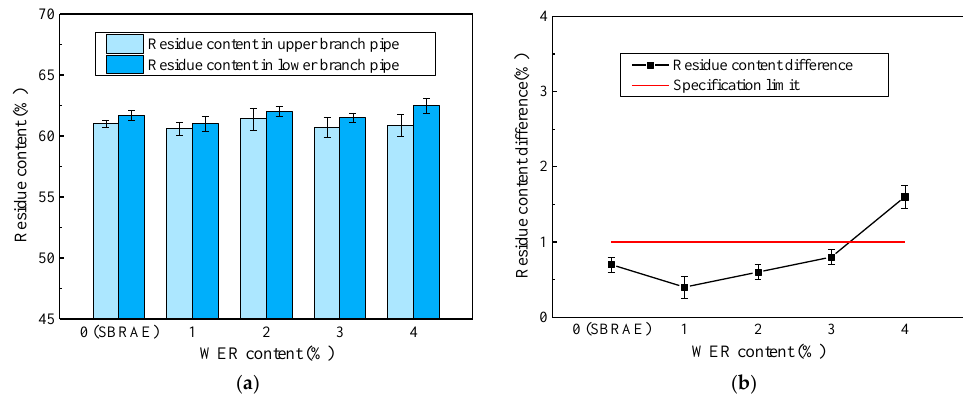
Figure 1. One-day storage stability of the waterborne-epoxy–styrene–butadiene rubber composite modified asphalt emulsion (WESAE) and SBRAE: ( a ) residue contents of upper and lower branch pipes; ( b ) change of residue content difference.